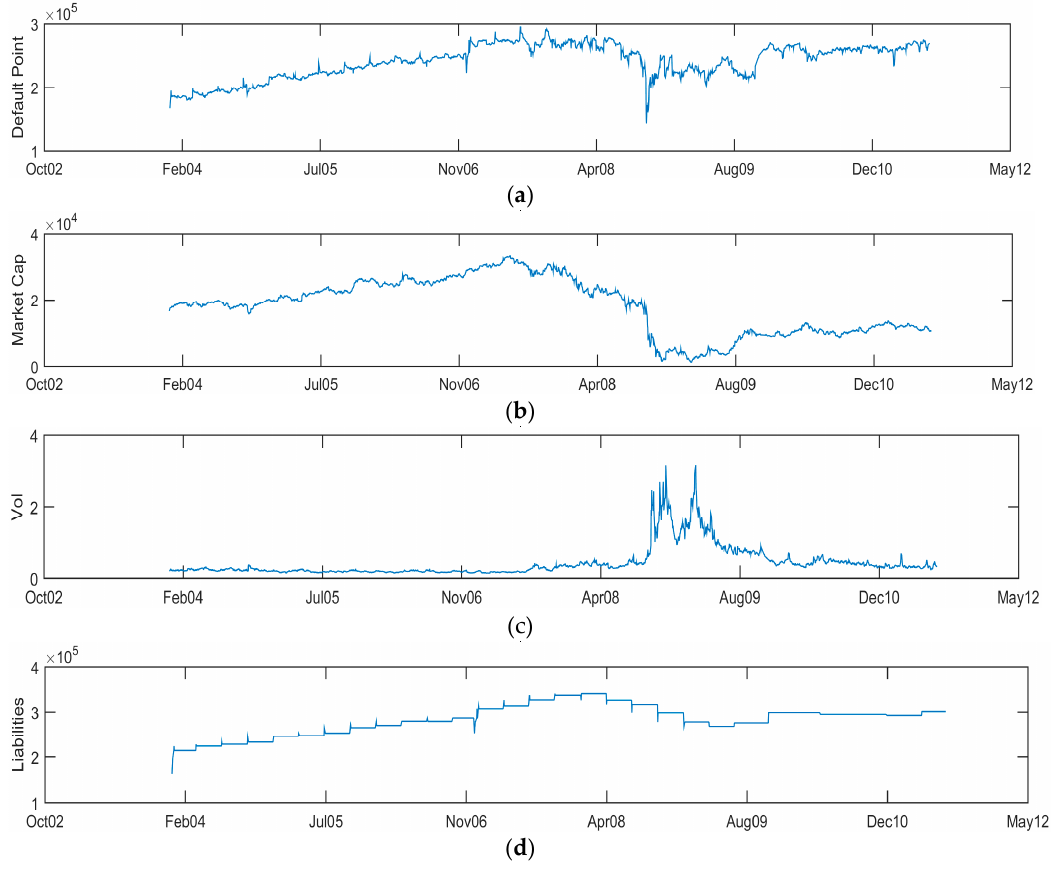
Figure 4. Hartford Financial Services time series for: (a) the default barrier; (b) market capitalization; (c) 10-delta implied volatility; (d) liabilities. (a,b,d) are in USD millions.